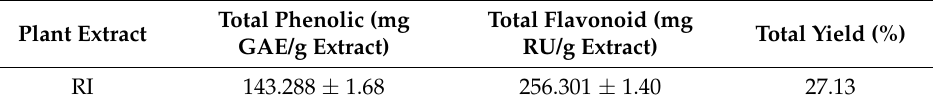
Table 1. Total phenolic and flavonoid content of Rabdosia inflexa (RI). Plant